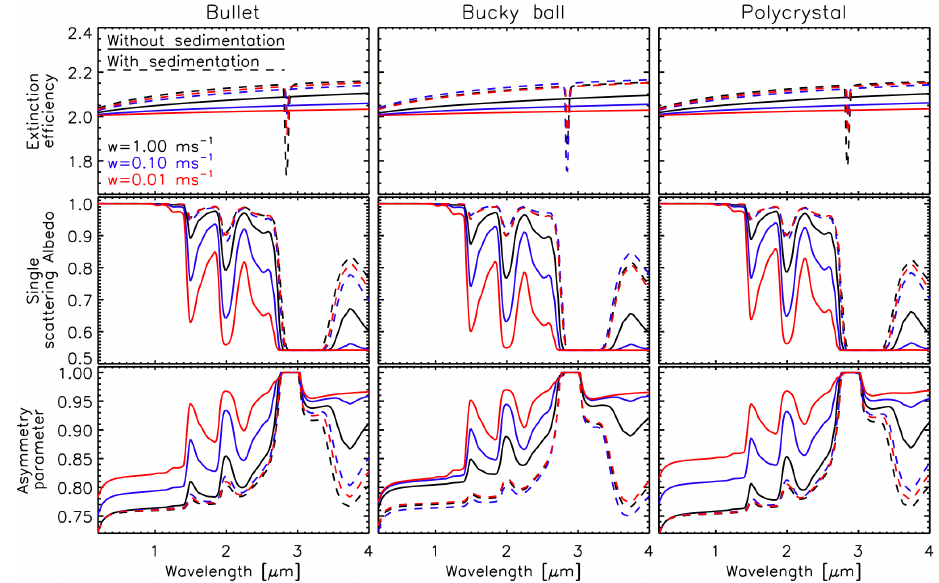
Figure 24. Optical properties of ice crystal size distributions shown in Fig. 17, as simulated at − 55 ◦ C with varying ice properties (bullet, Bucky ball and polycrystal: left to right) and varying updraft speeds (line colors per legend), with and without sedimentation (solid and dashed lines per